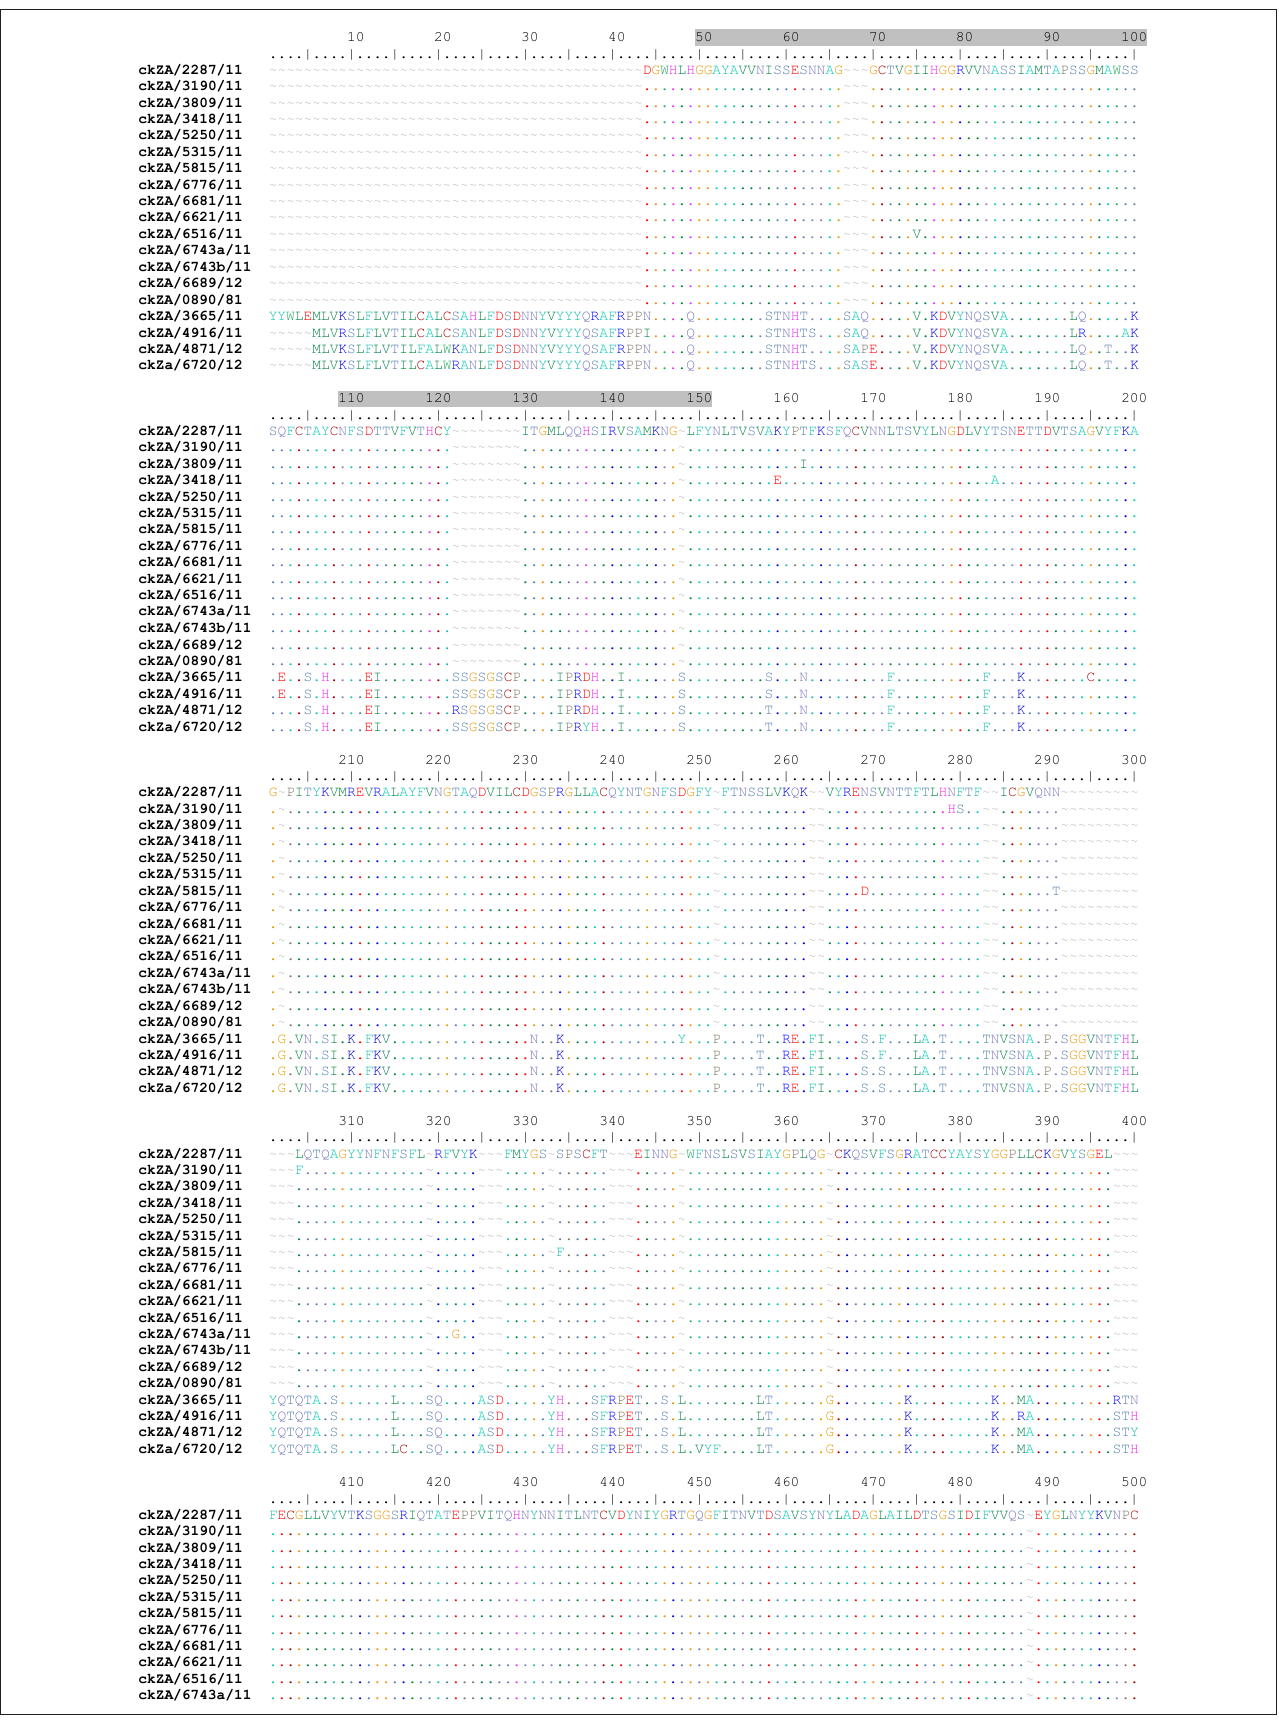
FIGURE 2: Multiple amino acid sequence alignment for full S1 proteins. Hypervariable regions are indicated in grey. The first sequence is used as a reference and identities are plotted as ‘.’.